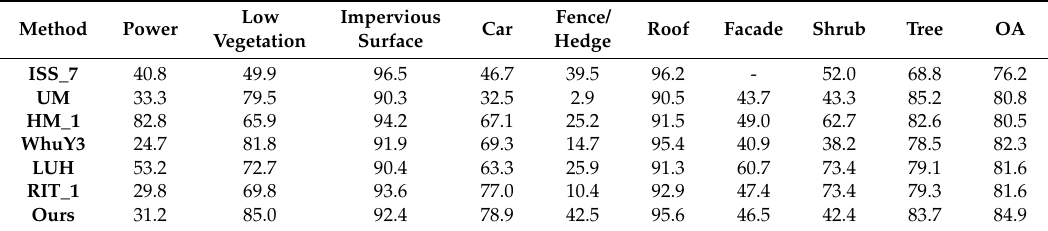
Table 5. A quantitative comparison between the per-class accuracy and the overall accuracy of our method and other published methods on the ISPRS test